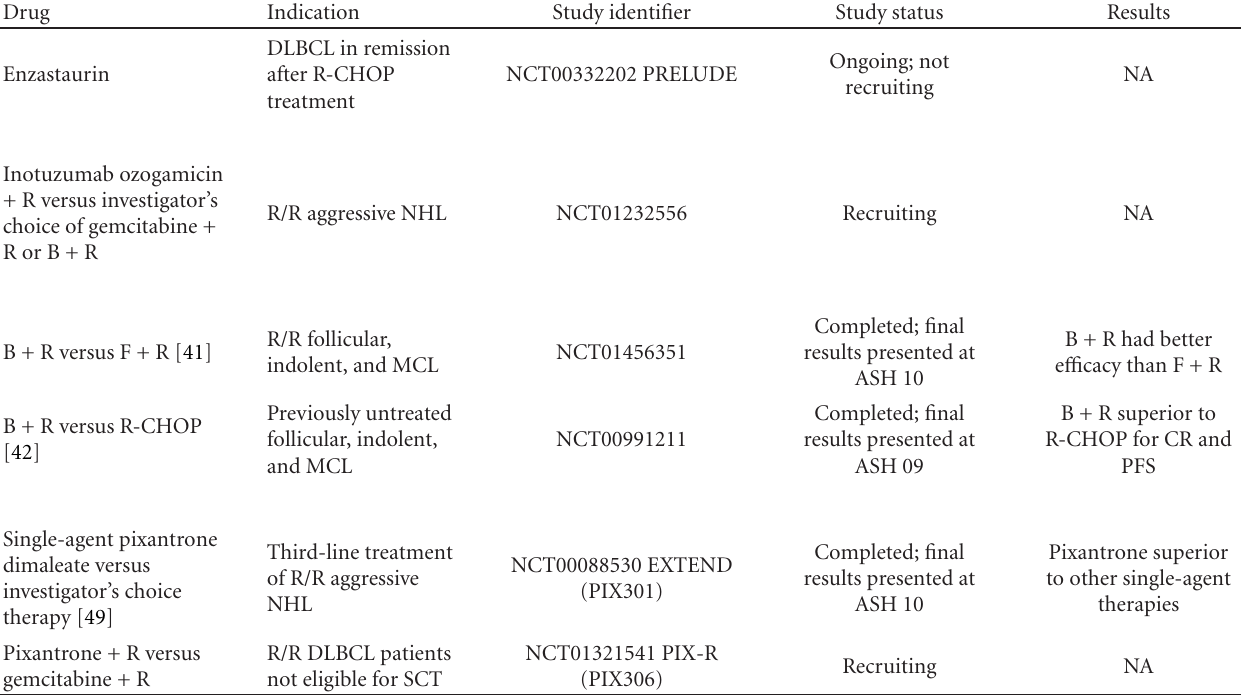
Table 7: Overview of ongoing or recently completed phase III studies mentioned in this paper, with agents in clinical development for the treatment of aggressive NHL. [B: bendamustine; CR: complete response; DLBCL: di ff use large B-cell lymphoma; F: fludarabine; MCL: mantle cell lymphoma; NA: not applicable; NHL: non-Hodgkin lymphoma; PFS: progression-free survival; R-CHOP: